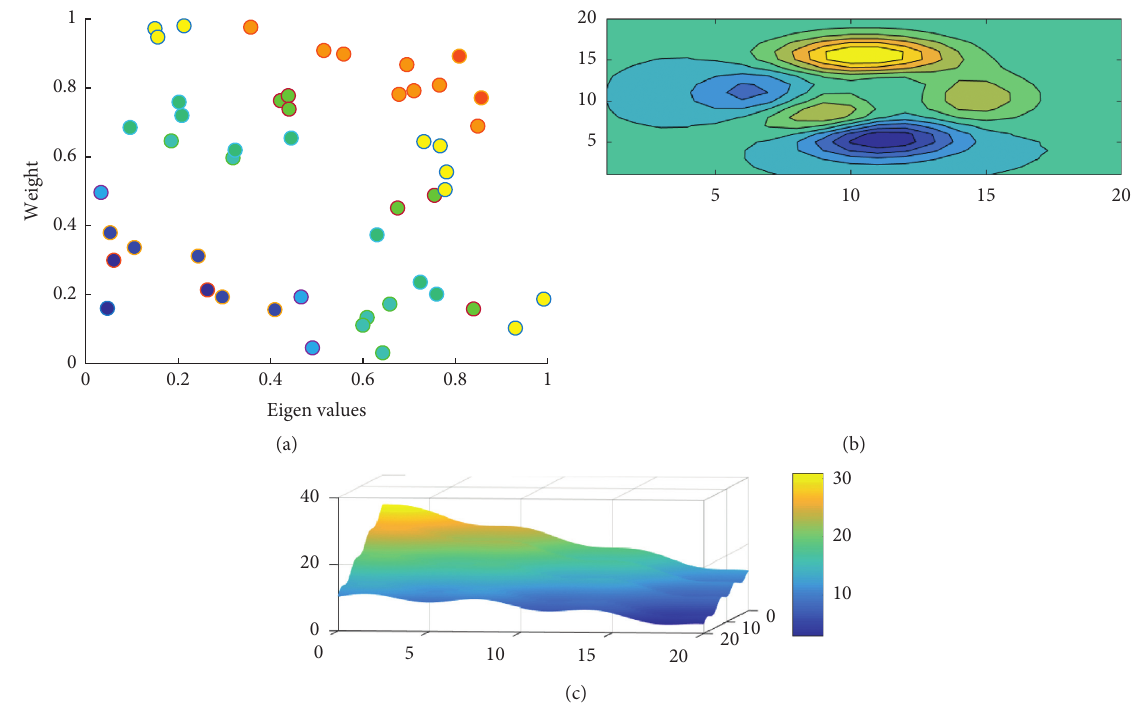
Figure 4: Multivisual animation pixel feature value discrete degree 3D fitting.